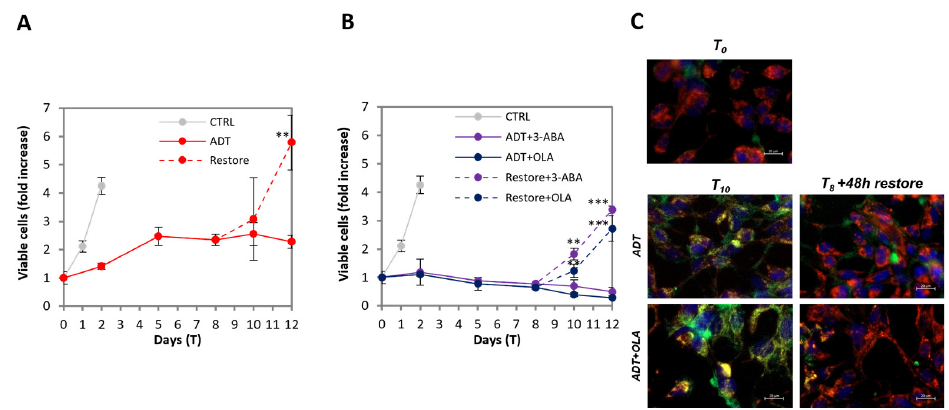
Figure 6. ADT-induced quasi-apoptotic state can be reverted by androgen restoration. ( A ) LNCaP cells treated with ADT for 8 days resume proliferation after androgen restoration. The profile shows the kinetics of viable (trypan blue-excluding) cell number expressed as fold over T0. Dashed line indicates androgen restoration. ( B ) Androgen restoration implies insensitivity to PARPi. The PARP inhibitors 3-ABA and OLA have no inhibitory effect on the proliferation of the rescued cells. The profile shows the kinetics of viable (trypan blue-excluding) cell number expressed as fold over T0. Dashed lines indicate androgen restoration. Statistical significance was calculated via Student’s T -test. ** p < 0.01 and *** p < 0.001, with respect to ADT-treated cells. ( C ) LNCaP cells treated with ADT ± OLA for 8 days can resume regular mitochondrial activity (red pattern) after 2 days of androgen restoration. Live cells staining of the mitochondrial mass (MTG, green), mitochondria with high transmembrane potential, mt ∆Ψ (MTR, red) and cell nuclei (Hoechst, blue) in wide-field micrography. The scale bar corresponds to 20 µ